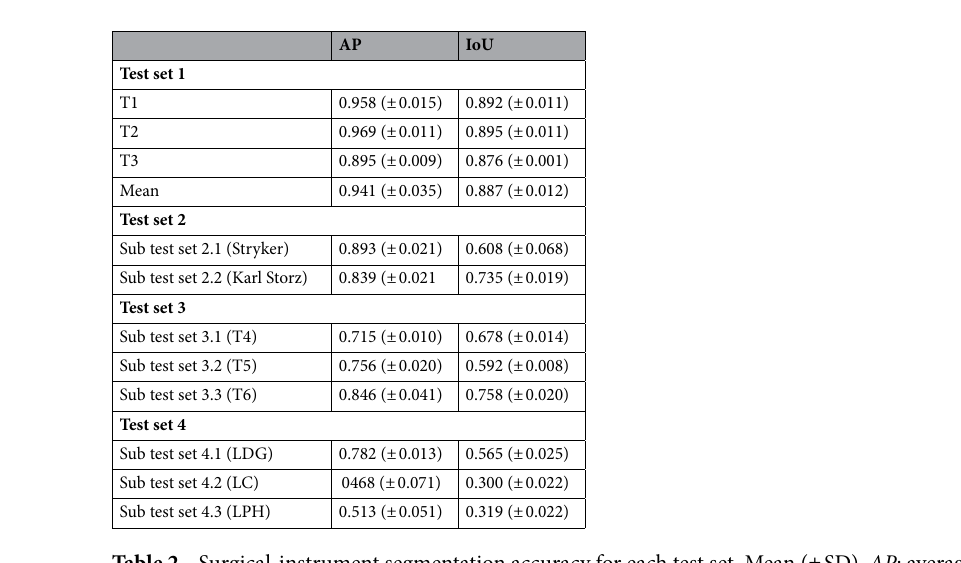
Table 2. Surgical-instrument segmentation accuracy for each test set. Mean (± SD). AP : average precision, IoU intersection over union, T1 harmonic shears, T2 endoscopic surgical electrocautery, T3 Aesculap AdTec atraumatic universal forceps, T4 Maryland, T5 Croce-Olmi, T6 needle holder, LDG laparoscopic distal gastrectomy, LC laparoscopic cholecystectomy, LPH laparoscopic partial hepatectomy, SD standard